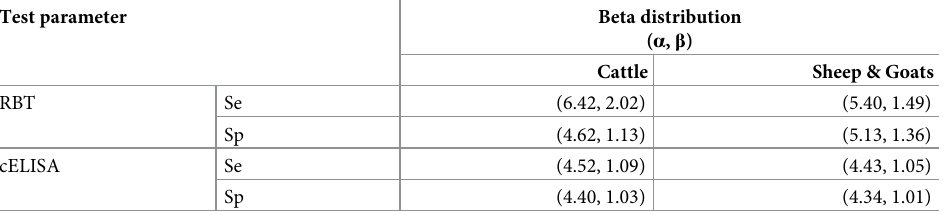
Table 1. Prior beta distribution shape parameters ( α , β ) for sensitivity and specificity of the RBT and cELISA for cattle, sheep and goats. Test